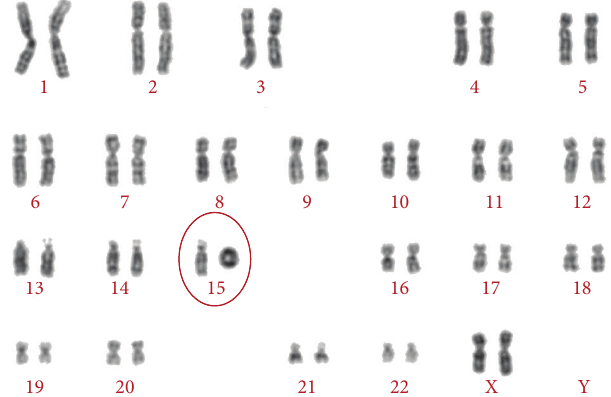
Figure 3: G banding of chromosomes revealed a ring chromosome 15, karyotype (46,XX,r(15) [20]